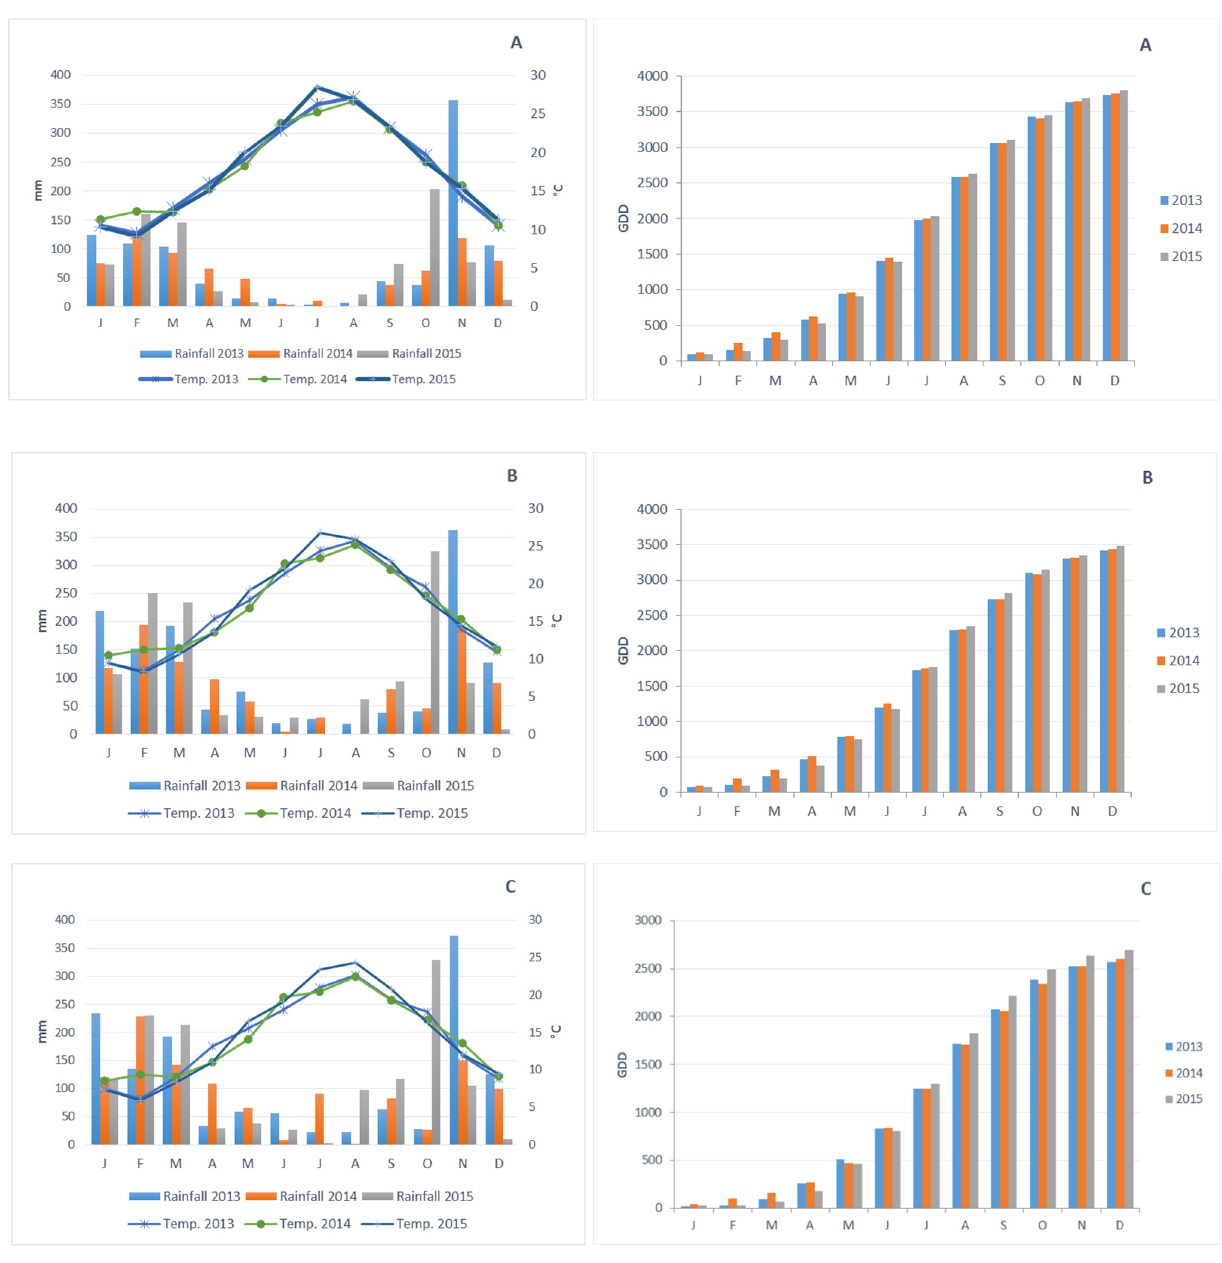
Figure 2. Mean monthly temperatures and changes in rainfall ( left figures ) and Total Growing Degree Days ( right figures ) from January to December in the three years (2013, 2014 and 2015) and in the three olive grove sites (site A, site B and site